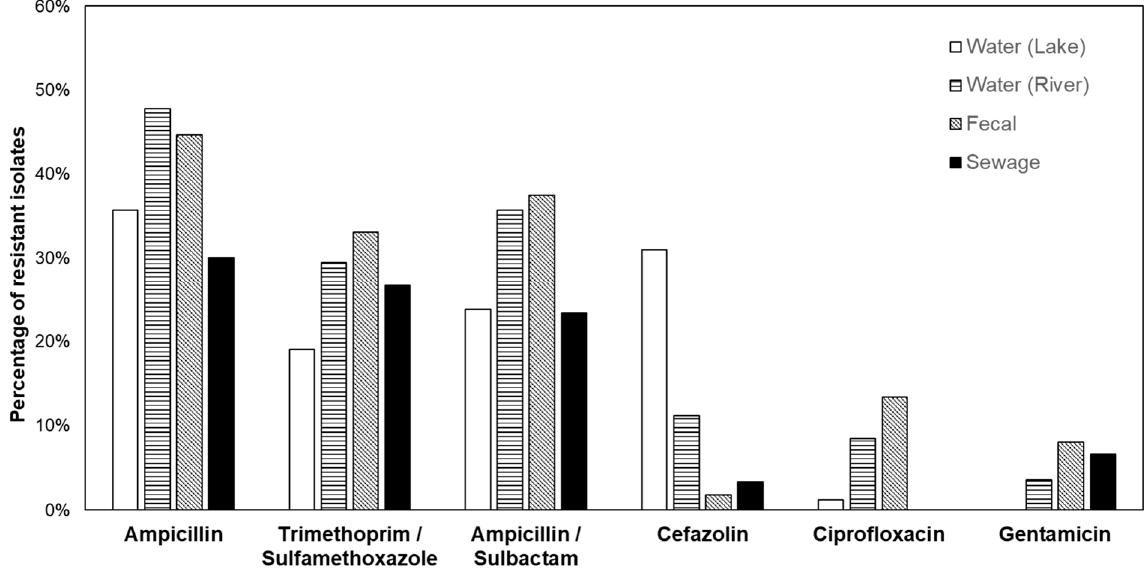
Figure 2. Occurrence of antibiotic resistance between fecal-associated and environmental isolates.